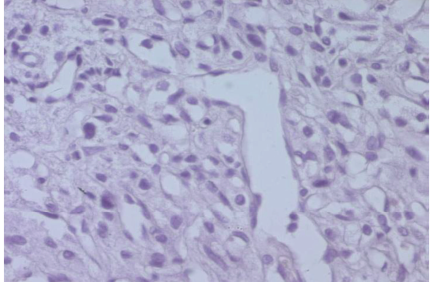
Figure 3: (HEx400) cells with round centrally nuclei with abundant clear cytoplasm.